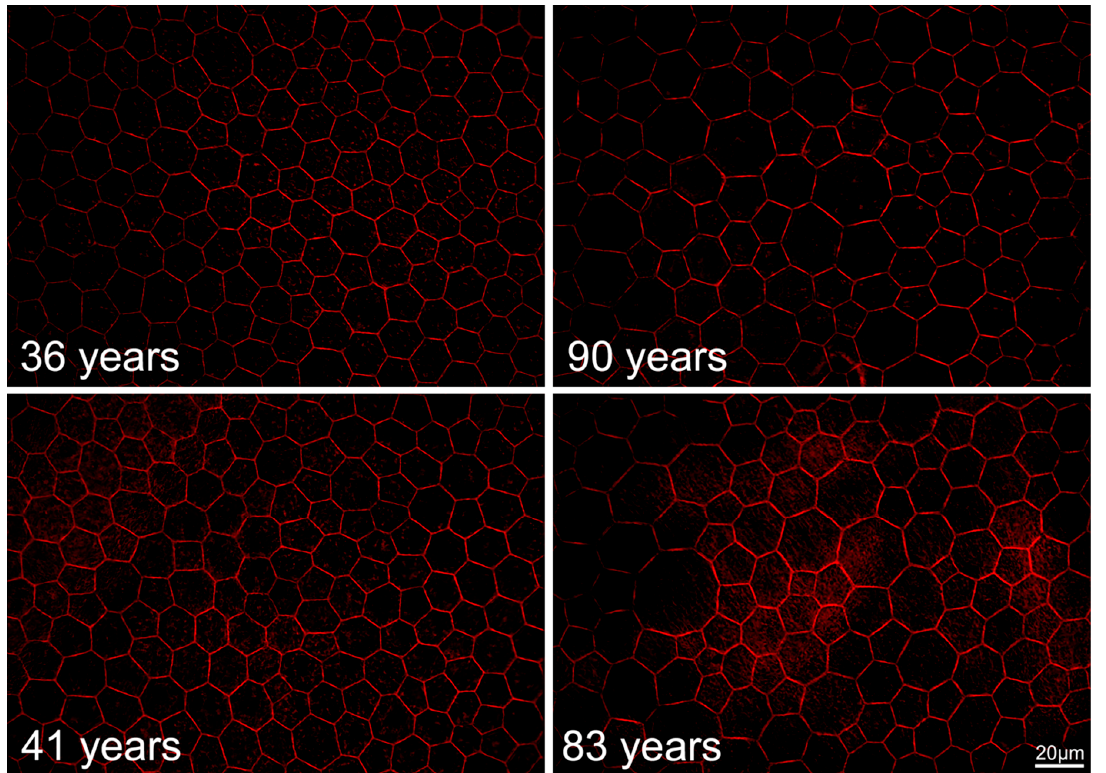
Figure 2. Age-related differences in the RPE cytoskeleton in normal eyes. In young humans (36, 41 years), a uniform geometry of polygonal, mostly hexagonal RPE cells is present, both at the fovea and near periphery. At older ages (83, 90 years) the strict geometry loosens and shows some enlarged cells.